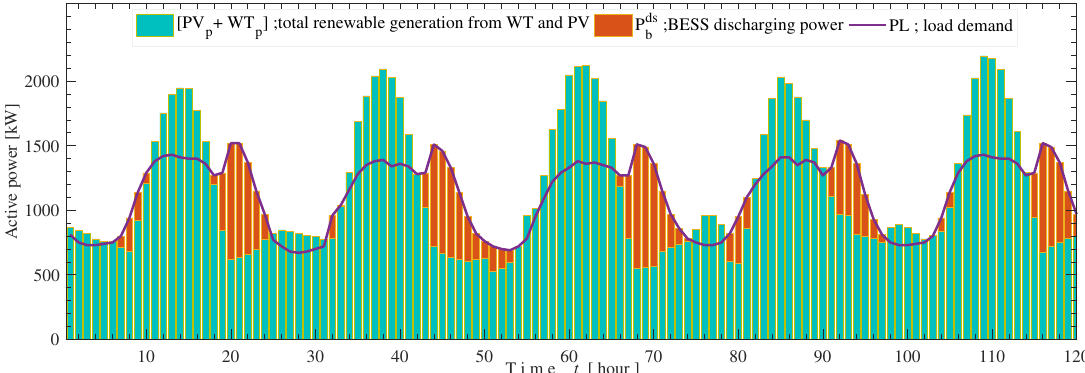
Figure 4. Aggregated renewable power generation, battery energy storage system (BESS) power and the load demand profiles without the consideration of the DSM strategy (case 1).